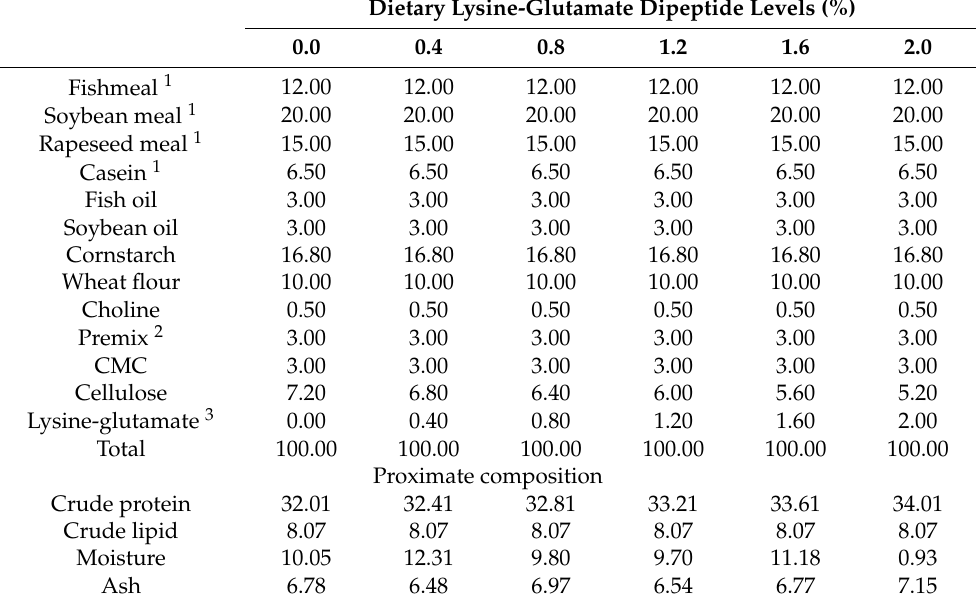
Table 2. Diet formulation and chemical composition of the lysine-glutamate dipeptide diets (% dry